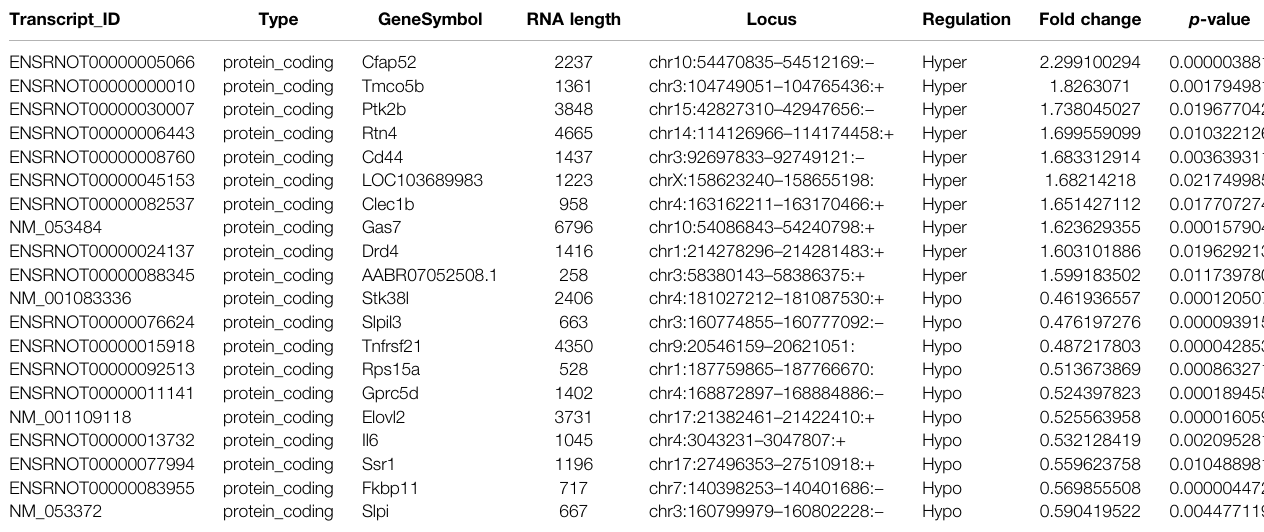
TABLE 2 | The detailed information of the top ten hyper-methylated and top ten hypo-methylated mRNAs.